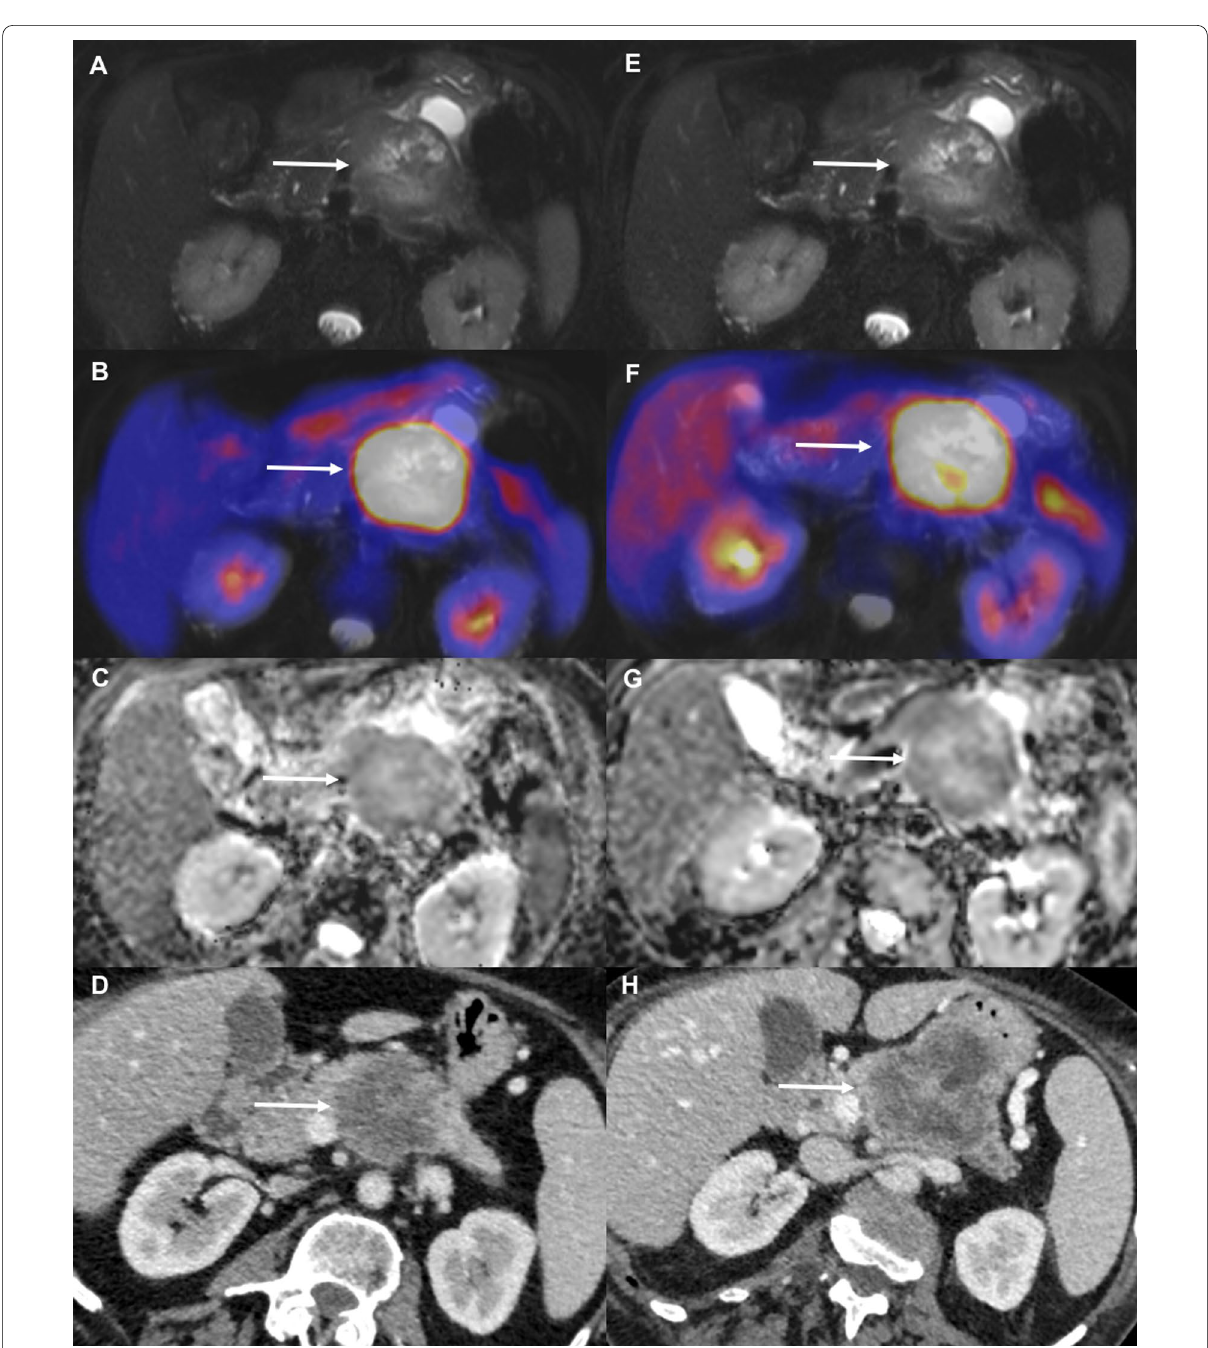
Fig. 5 Images from a 66y-old female patient with a PDAC in the pancreatic corpus. Images on the left ( a – d ) were obtained prior to chemotherapy, images on the right ( e – h ) were obtained 14 days later, after one cycle of palliative chemotherapy with FOLFIRINOX. Axial T2 FS images ( a , e ) display no significant change in tumor size. However, PET showed a significant increase in MTV 50% (33.8%) and TLG 50% (19.9%) ( b , f ). Additionally, only a slight increase in ADC mean (7%) was seen ( c , g ). The follow-up CT ( h ) after 78 days reveals progressive disease despite 6 cycles of FOLFIRINOX compared to the baseline CT ( d